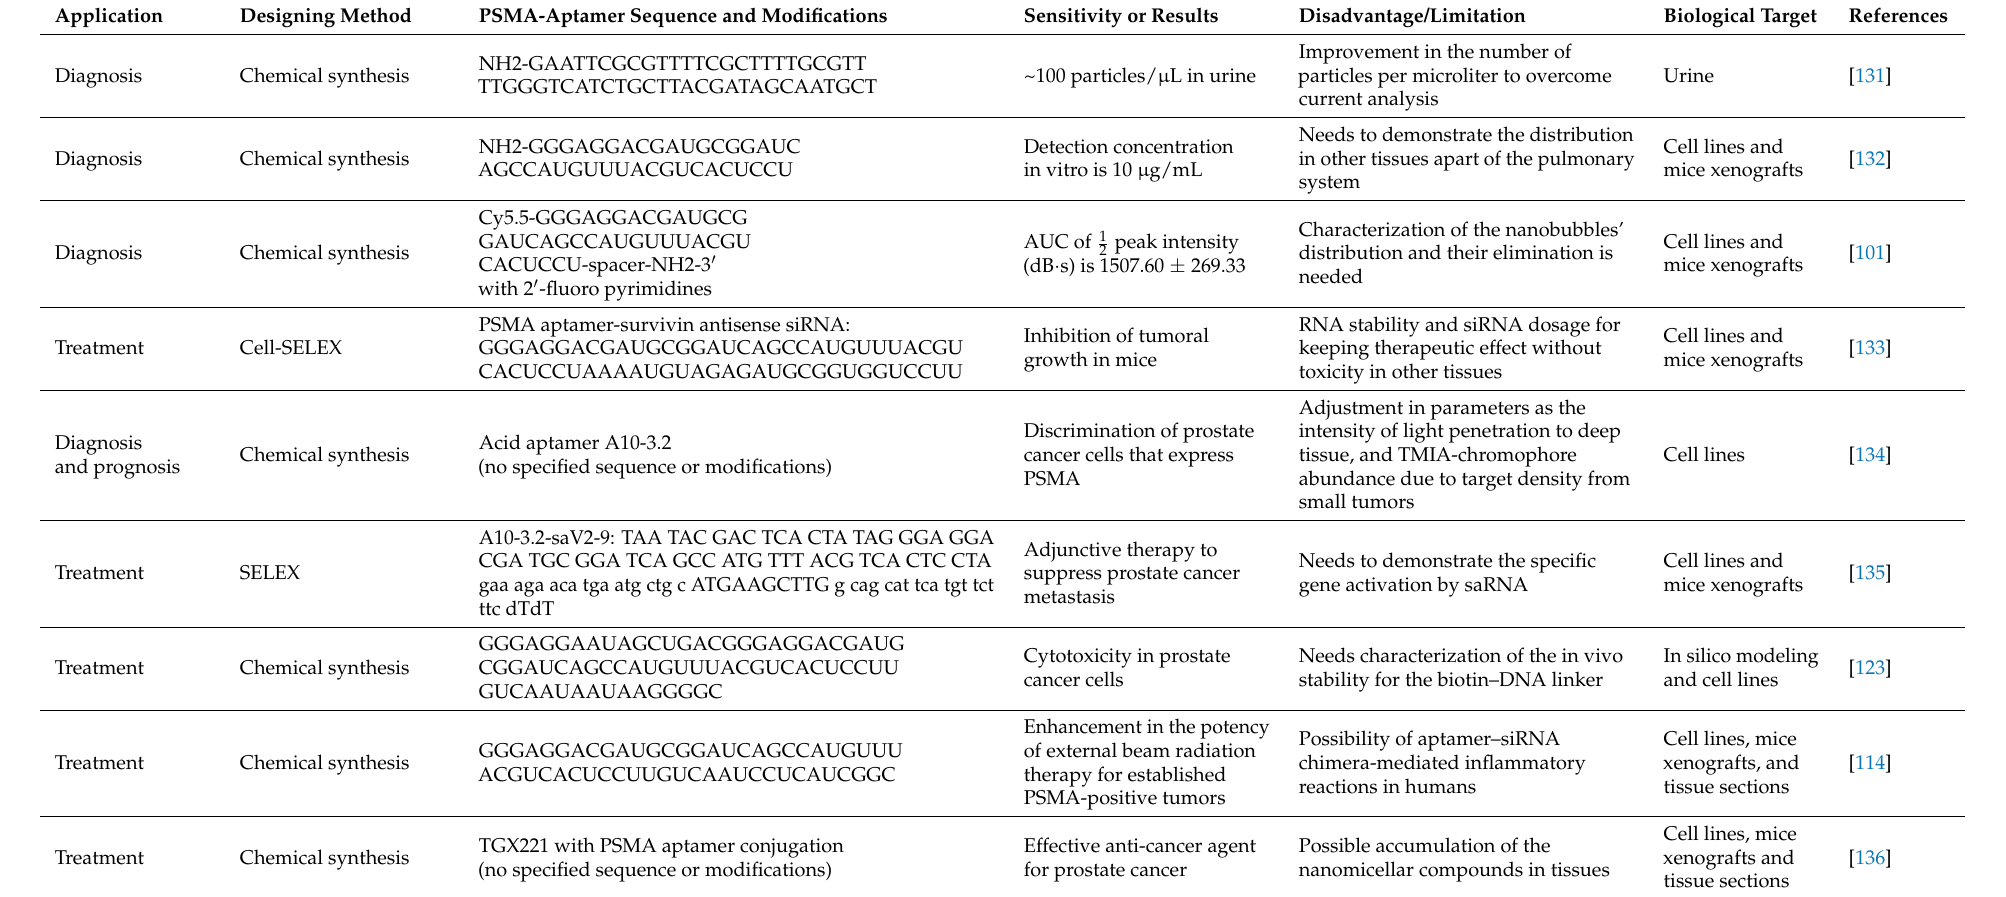
Table 4. Overview of PSMA aptamers and